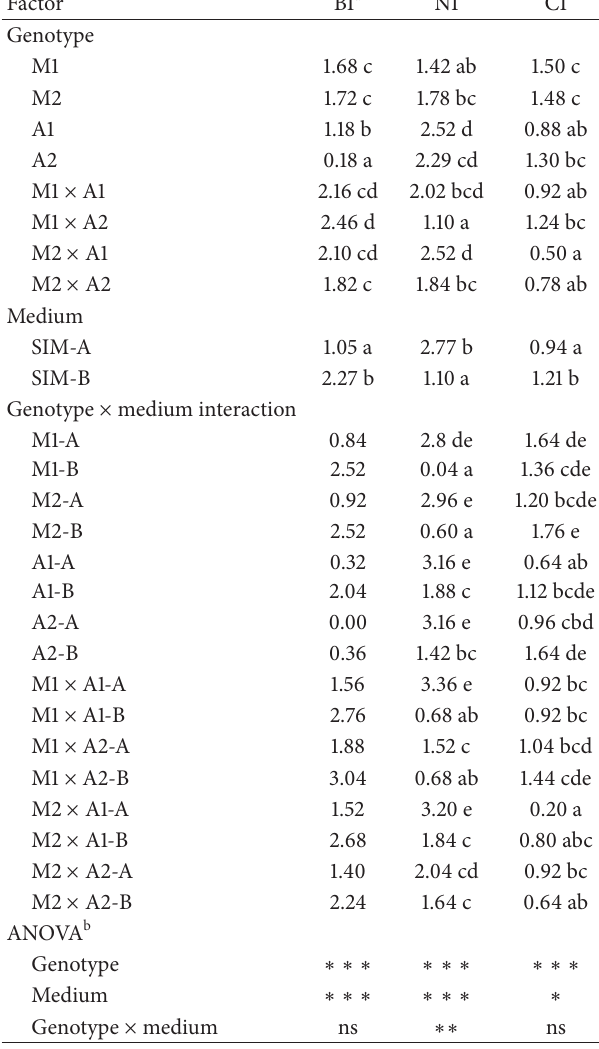
Table 2: Effect of genotype, culture medium, and their interaction on the bud index (BI), necrosis index (NI), and callus index (CI) after 20 days of culture in shoot induction media (SIM-A or